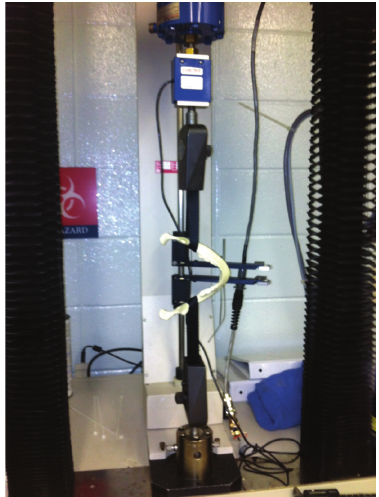
Figure 6: Sample positioned for mechanical testing in the Sintech 2/G servohydraulic materials testing unit.